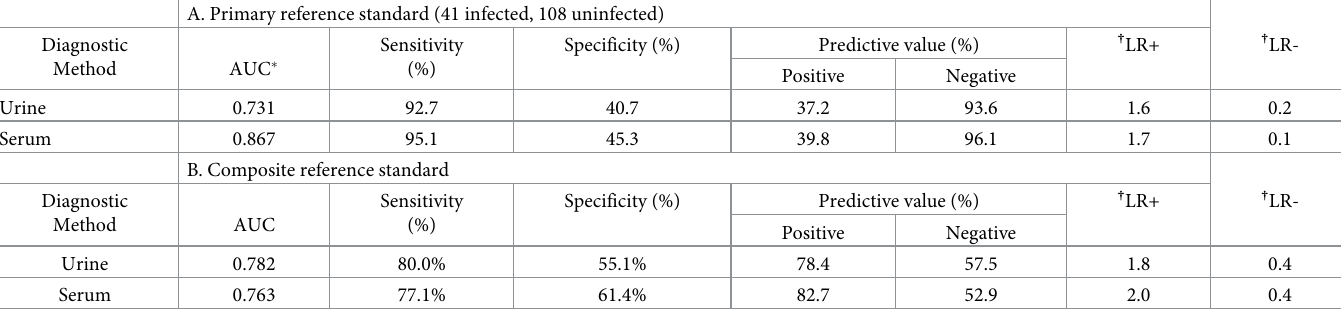
Table 2. Diagnostic performance of antibody detection by the urine assay and serum assay compared with the primary and composite reference standard. A. Primary reference standard (41 infected, 108